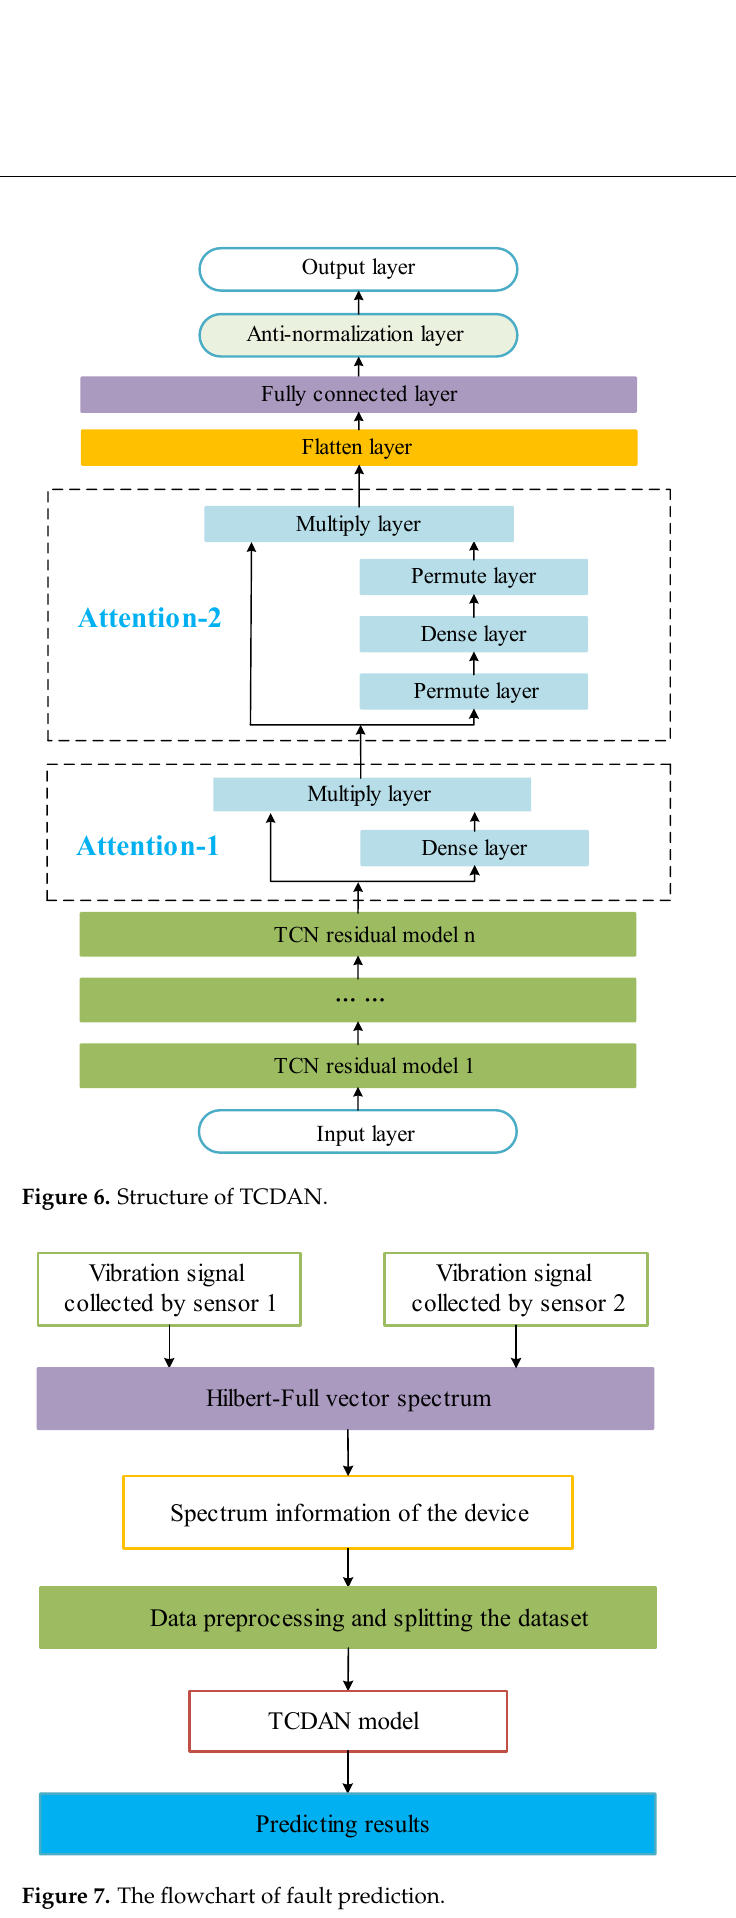
Figure 7. The flowchart of fault prediction.